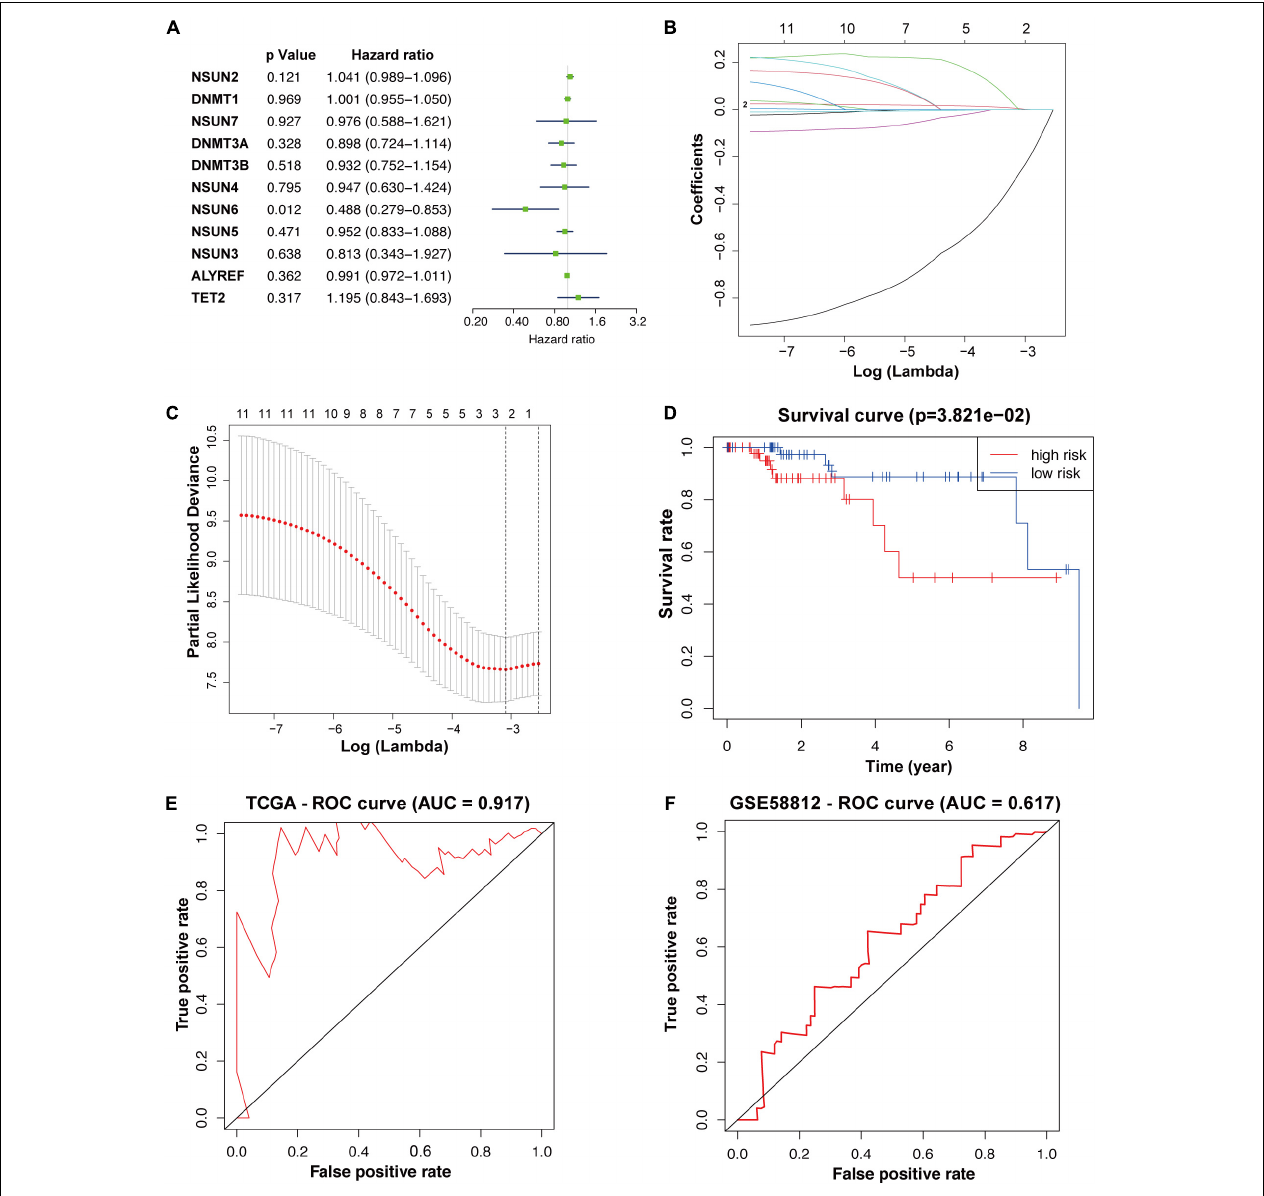
FIGURE 2 | Construction of prognostic risk signature for TNBC patients with two survival-related genes. The p -value, HR value, and 95% confidence interval of the 11 m5C RNA methylation regulators analyzed using univariate Cox regression analysis (A) . Using LASSO Cox regression, two m5C RNA methylation regulators were selected for risk coefficient calculation (B,C) . Kaplan-Meier overall survival curves based on the risk signature (D) . ROC curves verified the specificity and sensitivity of the risk signature prediction in the TCGA database and the GEO dataset (GSE58812) (E,F). TNBC, triple-negative breast cancer; ROC, operating characteristic